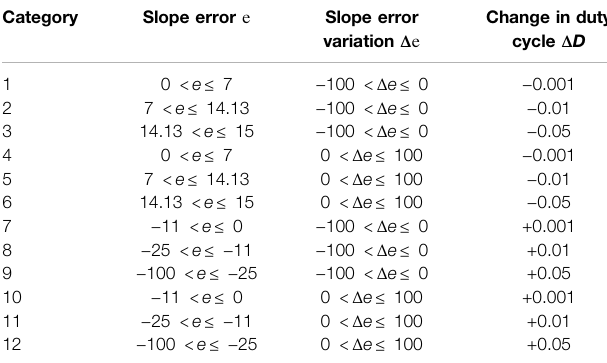
TABLE 2 | Extension matter-element models of 12 categories. Category Extension matter-element